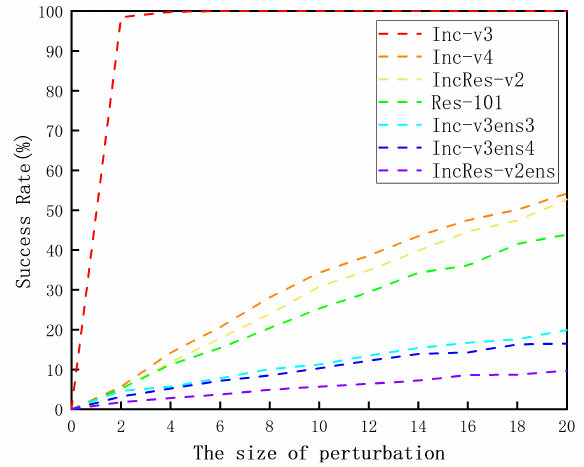
Figure 5. Attack success rates (%) of NAI-FGM on seven networks with Inc-v3 as the origin model with different sizes of perturbation.